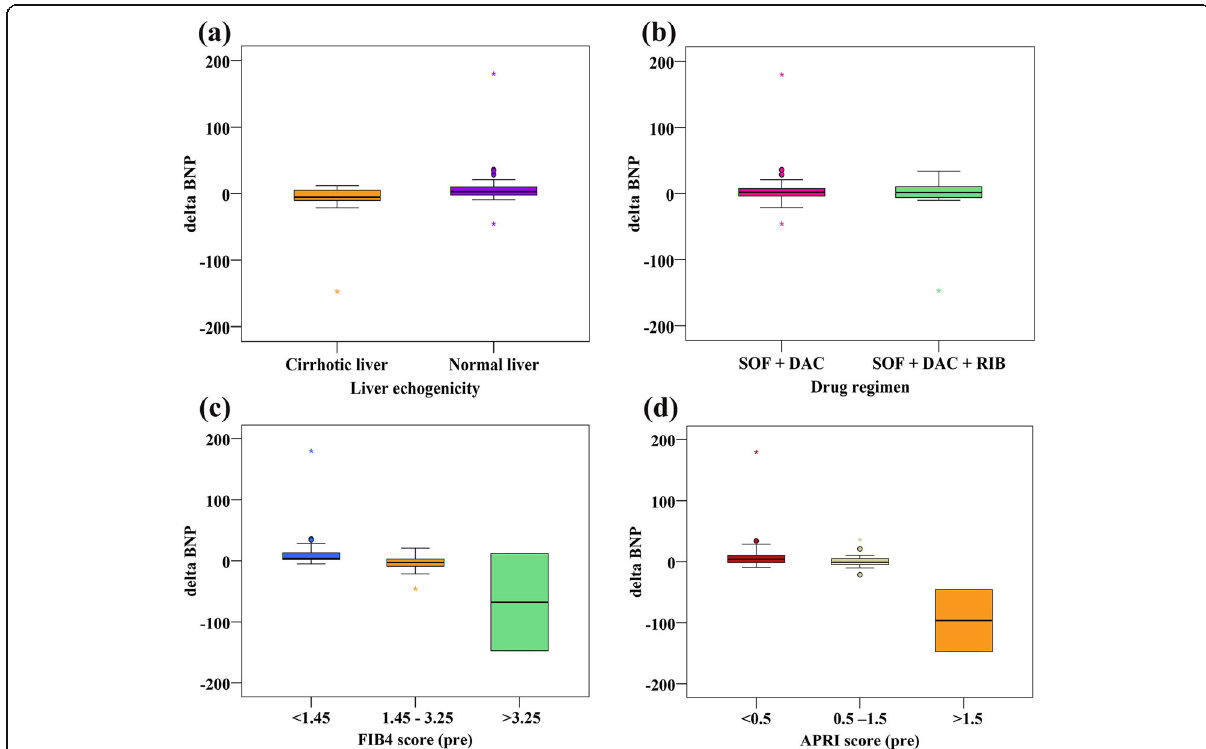
Fig. 2 a Relation between delta BNP and echogenicity of the liver. b Relation between delta BNP and drug regimen (with and without ribavirin). c Relation between delta BNP and pretreatment FIB4 score. d Relation between delta BNP and pretreatment APRI